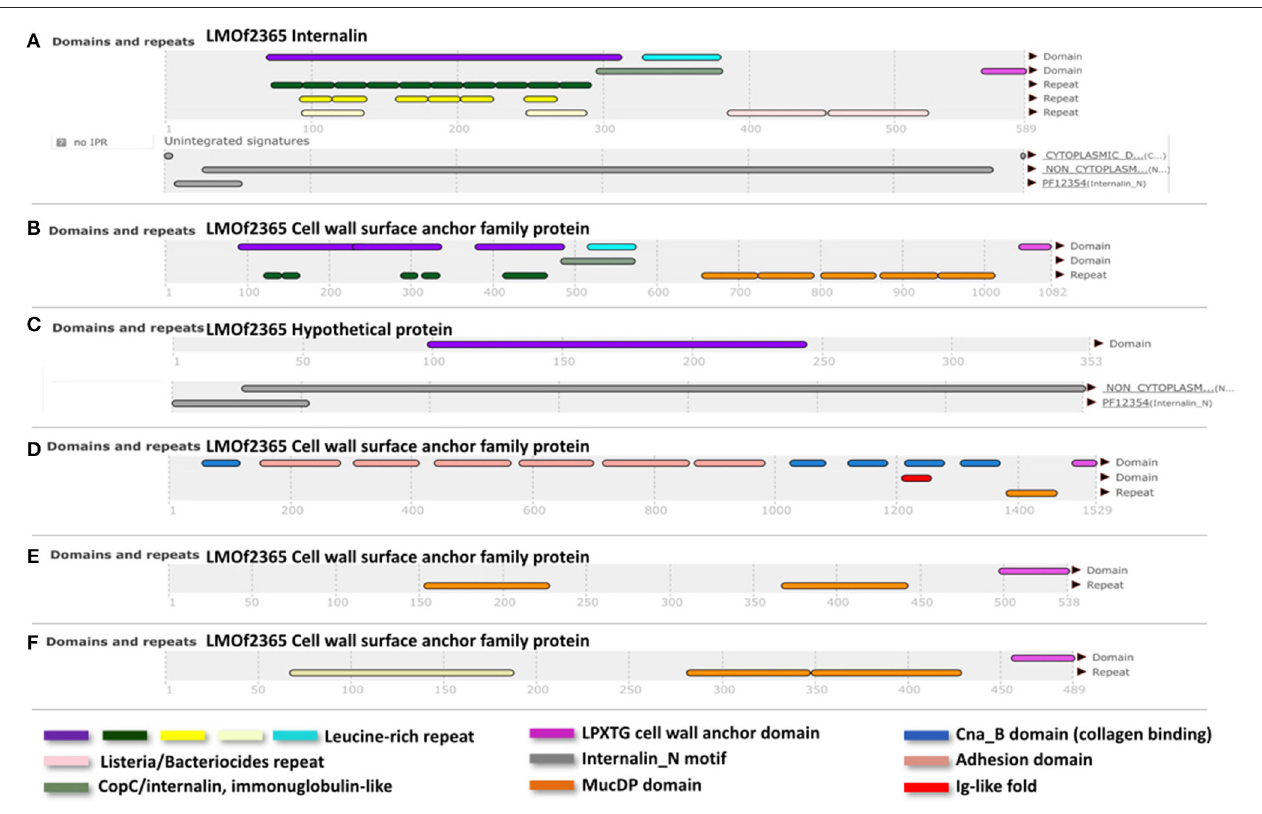
FIGURE 3 | InterPro (Apweiler et al., 2000) results of the translated sequences for the six selected genes. (A) , Internalin (LMOF2365_RS01905); (B) , (LMOF2365_RS06250); (D) , (LMOF2365_RS11140); (E) , (LMOF2365_RS03470), and (F) , (LMOF2365_RS13380); Cell wall surface anchor family proteins. (C) Hypothetical protein. Nomenclature of gene products was taken from the strain F2365 annotation (lineage I).